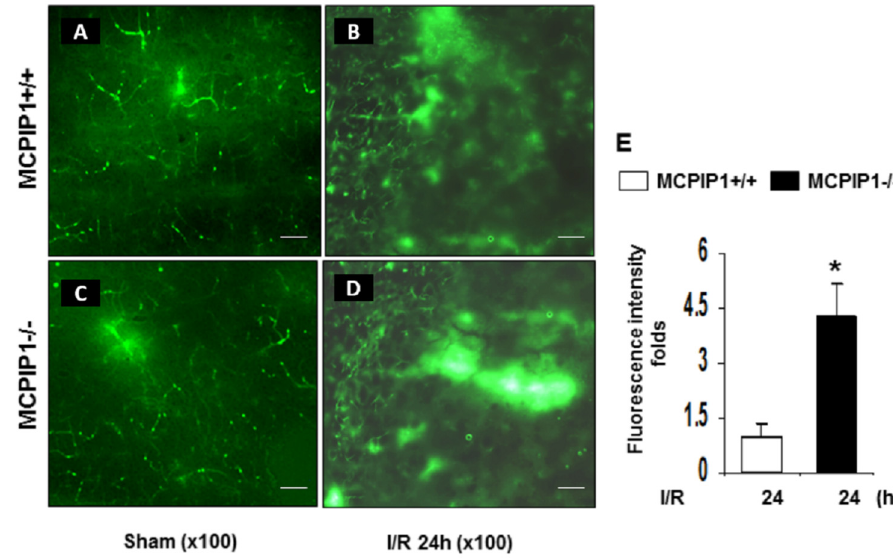
Figure 2. MCPIP1 deficiency exacerbates extravasation of fluorescein isothiocyanate (FITC)-dextran in the injured regions of the brains after 24 h reperfusion following MCAO. ( A – D ) Representative images of FITC-dextran extravasation in the brains from the MCPIP1 – / – mice and their wild-type littermates underwent 2 h MCAO followed by 24 h reperfusion. ( E ) Measurement of fluorescence intensity in the ischemic tissue. The MCPIP1 – / – mice had a significant increase in the leakage of FITC-dextran compared to their wild-type littermates after 2 h of MCAO and 24 h of reperfusion. Values represent mean ± SD, * p < 0.05 versus wild-type group. n = 6 per group. Scale bar, 25 µm.